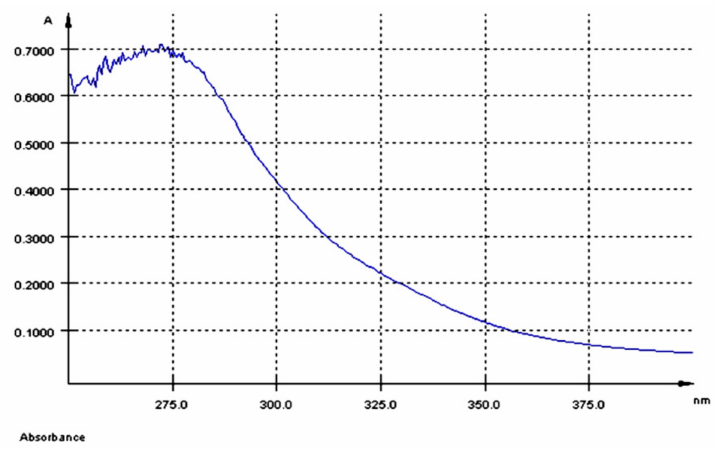
Figure 1. UV-Vis spectrum of the aqueous grape pomace extract (AGP).